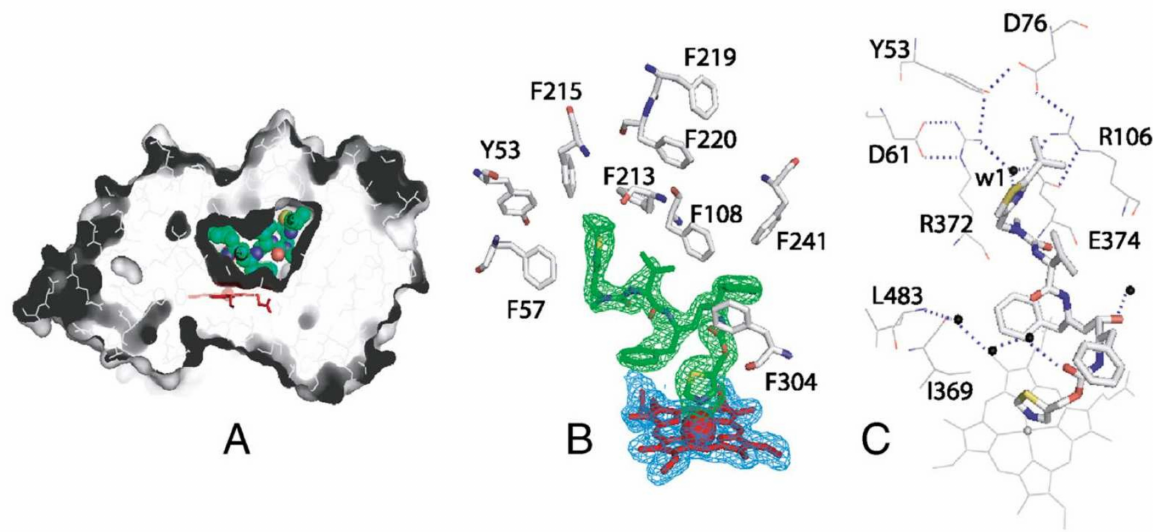
Figure 4. Crystal structure of the complex between CYP3A4 and ritonavir. ( A ) The active site cavity of ritonavir-bound CYP3A4, in which ritonavir is depicted in green and the heme in red. This illustrates that ritonavir is totally sequestered from surrounding water. ( B ) Aromatic residues surrounding ritonavir supporting the hydrophobic interactions inside the active site. Blue and green indicate the electron density around ritonavir and the heme. ( C ) An umbrella-like charge–charge/H-bonding network connected to the isopropyl-thiazole moiety of ritonavir via the highly ordered water molecule (w1), illustrating the electrostatic interactions with ritonavir. Reprinted with permission from [61], 2010,